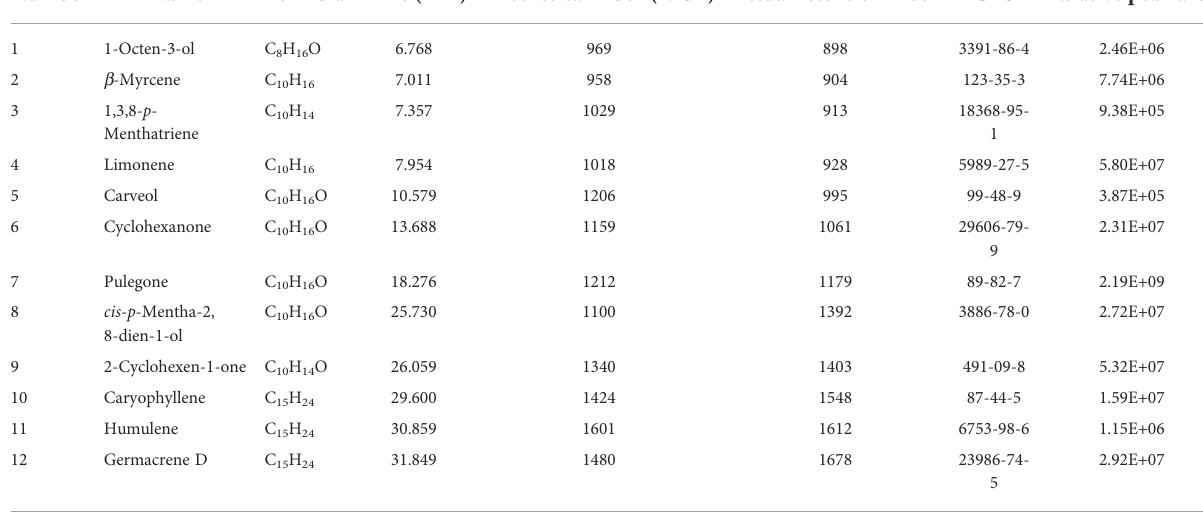
TABLE 1 The GC-MS analysis of compounds from